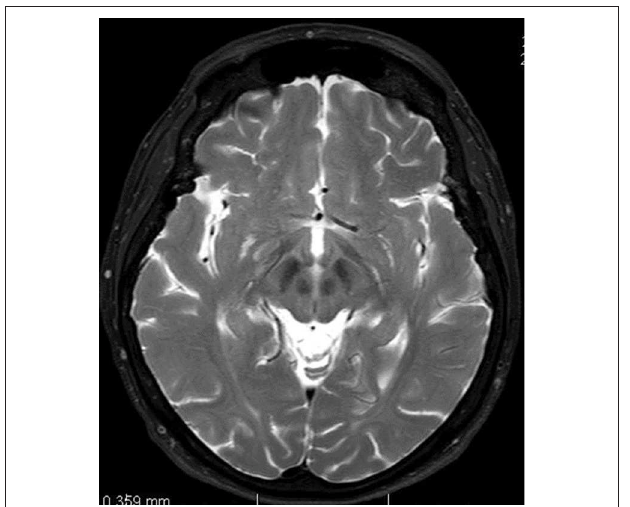
FIGURE 1 | Magnetic resonance imaging of brain. T2-weighted axial scan. Changes in midbrain retrospectively evaluated as so-called face of giant panda sign.